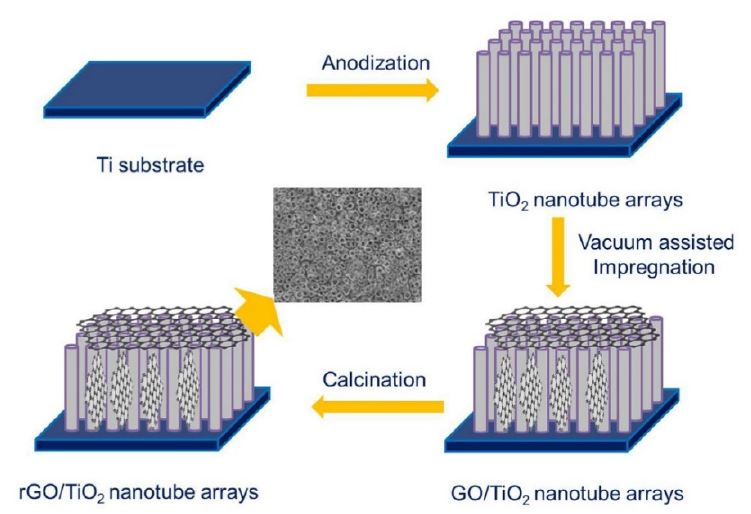
Figure 8. Scheme for the fabrication of rGO/TiO 2 photoelectrode. Reprinted with permission from